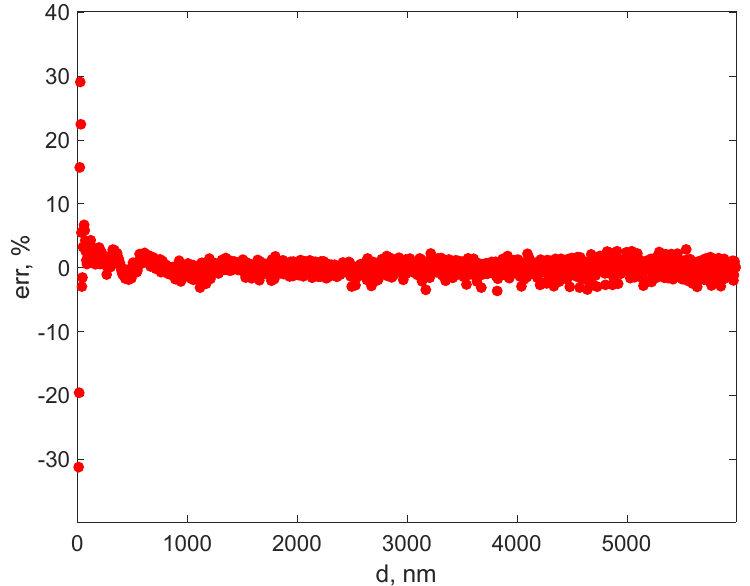
Figure 7. The relative errors in assessing the d SEN diameters